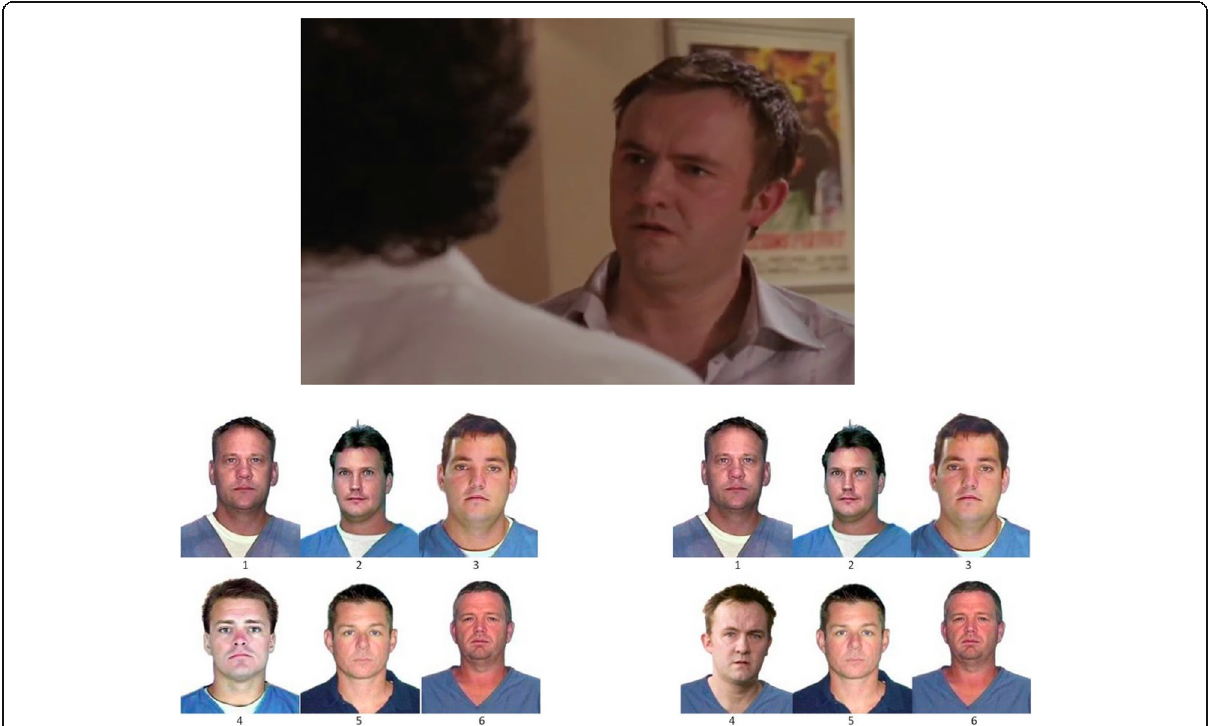
Fig. 1 Examples of crime video and lineup materials. The best view of the criminal in the video is included, along with culprit-absent (left) and culprit-present (right)